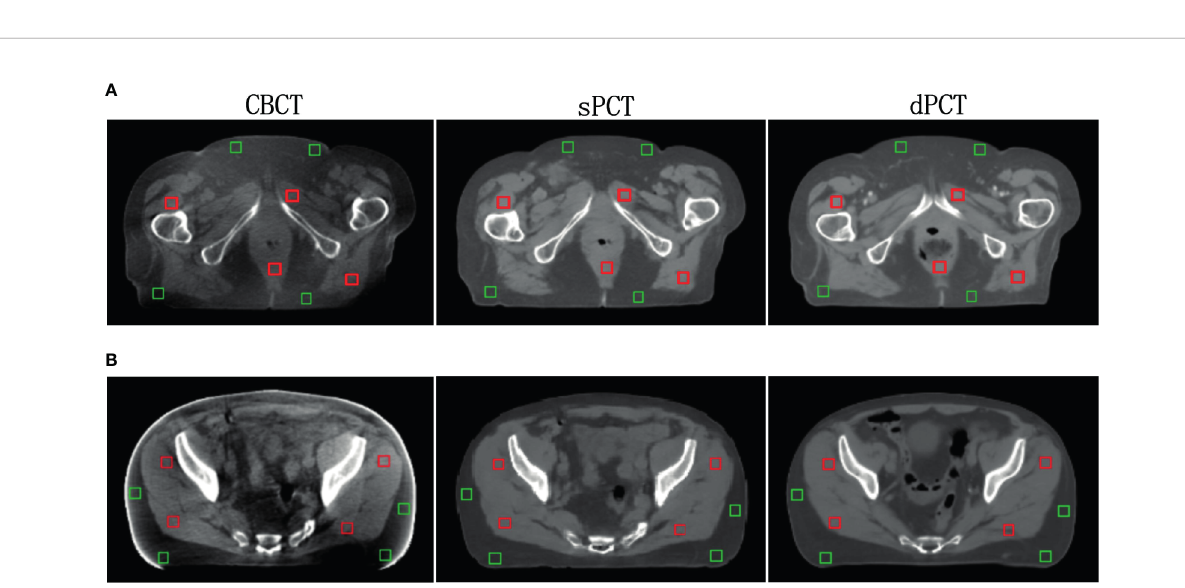
FIGURE 9 | Distribution of the region of interests (ROIs). Two rows (A, B) represent the axial images of two patients respectively. The left, middle, and right images are CBCT, sPCT, and dPCT respectively. The green rectangle represents the fat ROIs, and the red rectangle represents the muscle ROIs. The corresponding ROI is placed in the same position on the CBCT, sPCT, and dPCT respectively. Each ROI contains 15 × 15 pixels. The display window is (700, 1300)